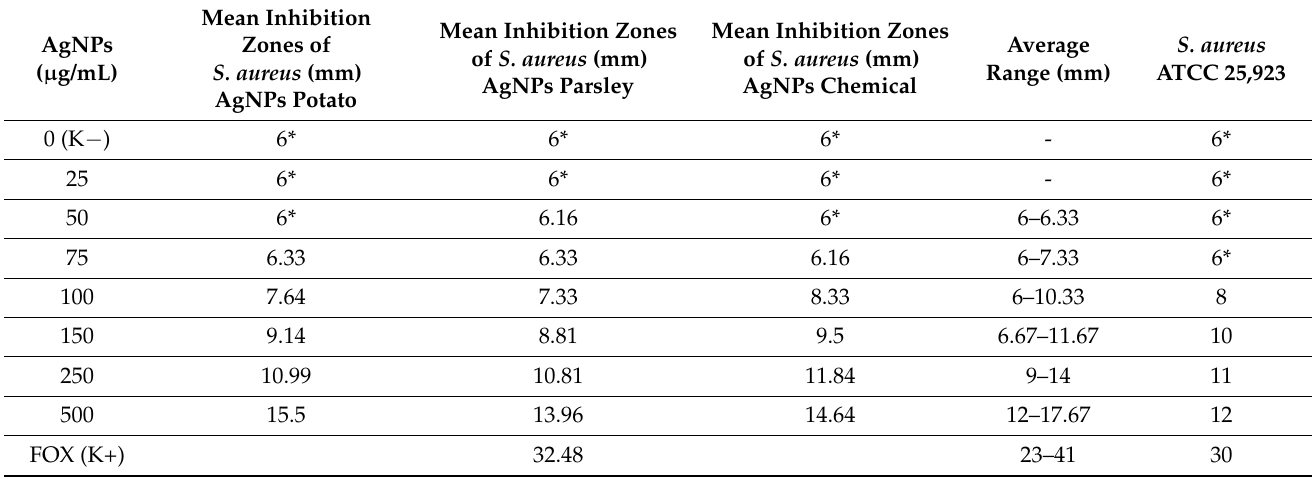
Table 3. Antibacterial activity of nanosilver on S. aureus and cefoxitin as a positive control.